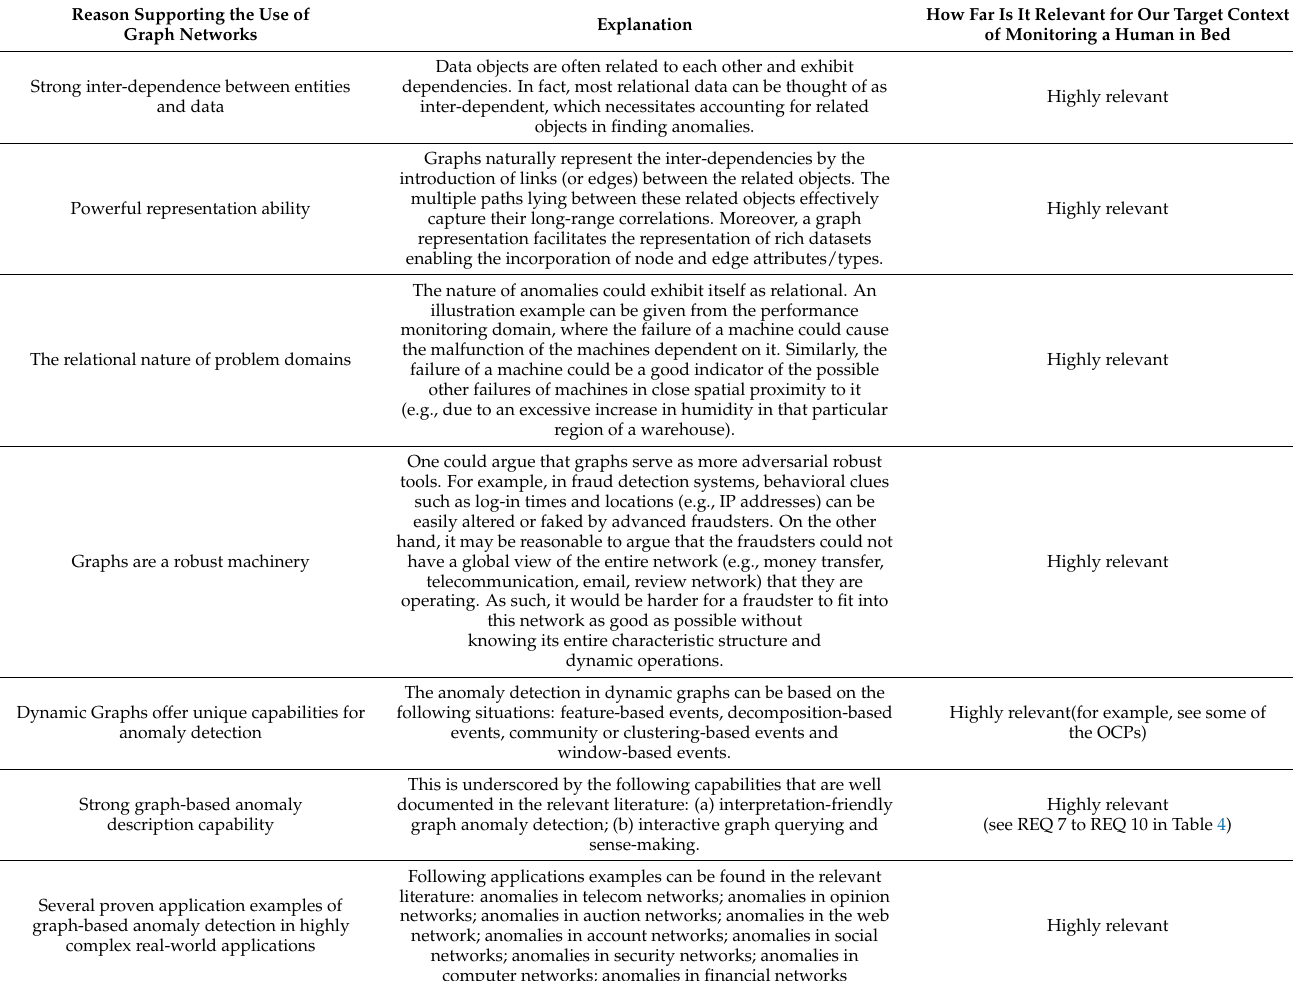
Table 6. Discussion of comprehensive main seven reasons [48] that make graph-based approaches to anomaly detection vital and